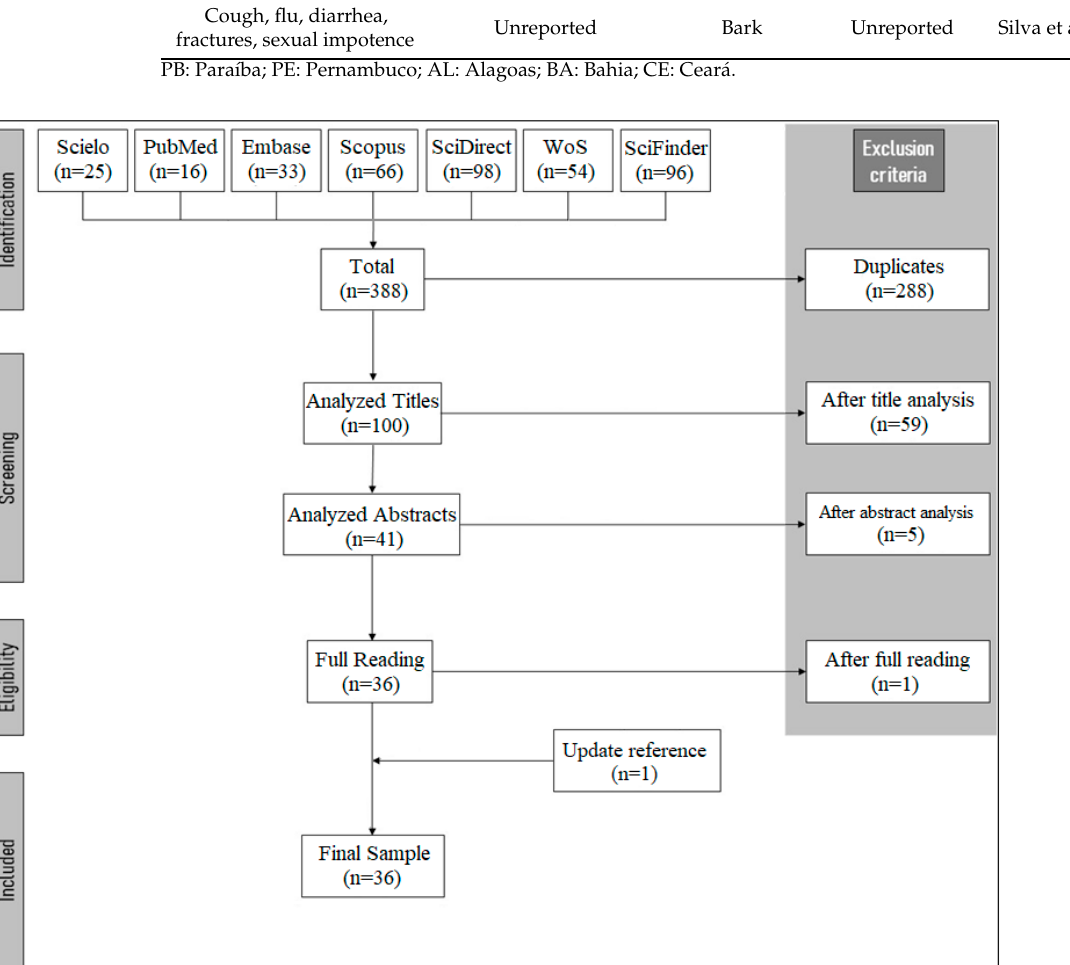
Table 1. List of therapeutic indications of Schinopsis brasiliensis Engler according to the results of the ethnobotanical surveys.